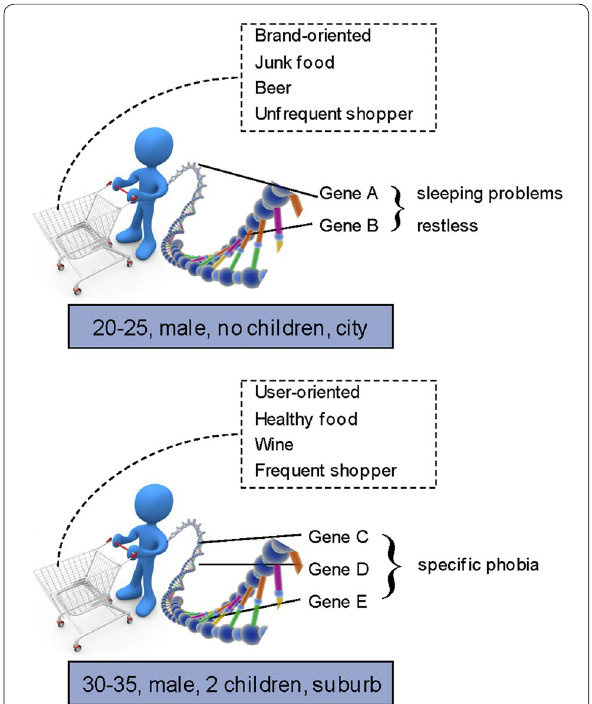
Fig. 1 Outline of the overall approach. A main goal of market research is to identify rules that predict customer habits based on market baskets. In the cartoon, a male customer between 20 and 25 without children living in the city favours junk food and beer and when he goes shopping he will most likely buy brands. Adapting this idea to genetic research we try to identify those genetic factors from the plethora of genetic factors in the “market basket” that are characterized by specific phenotypic features (like specific phobia or restlessness). The cartoon contains graphical depictions by Benjamin Albiach Galan and Konstantinos